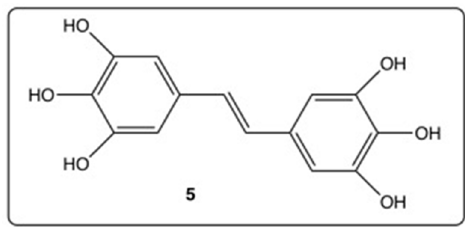
Figure 4 . Structure of 3,4,5,3 ′ ,4 ′ ,5 ′ -hexahydroxystilbene ( 5 ) bearing two pyrogallol groups.